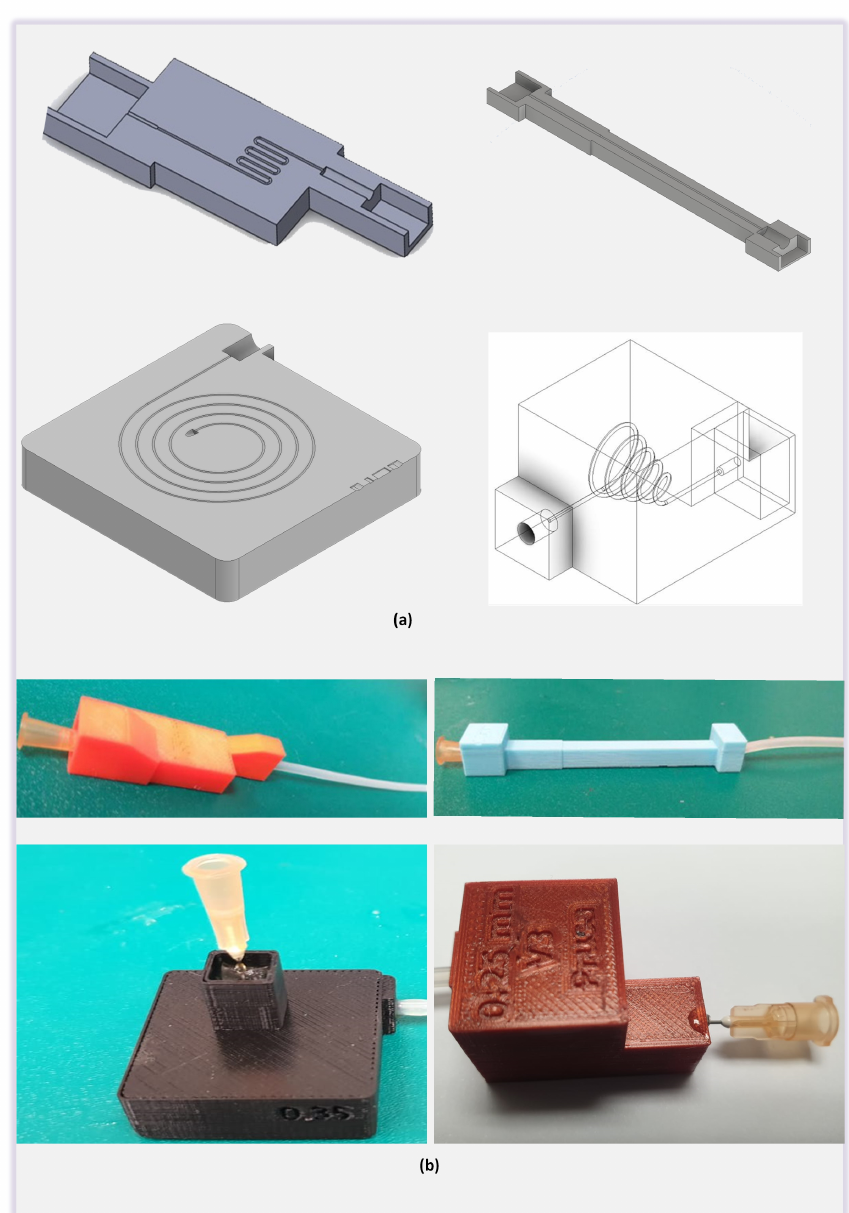
Figure 2. ( a ) CAD models of the linear, curved, spiral and helical microchannels ( b ) Pictorial view of the connected inlet and outlet ports of the FDM printed linear, curved, spiral and helical